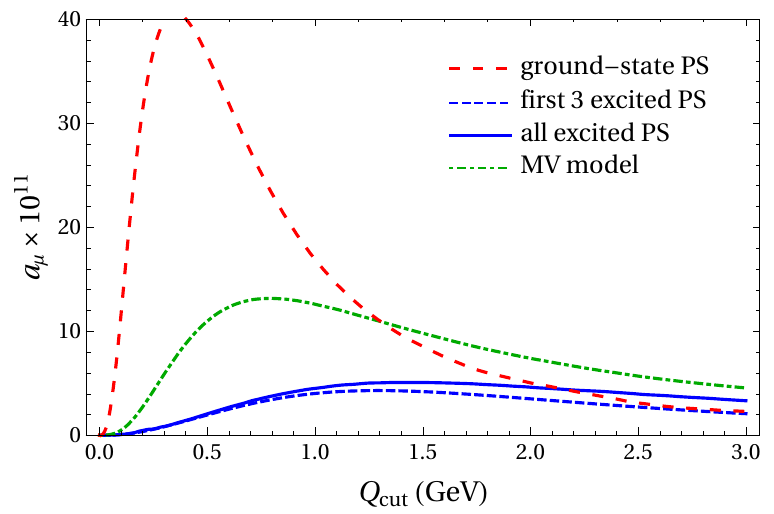
Figure 16. Mixed-region contribution to a (cid:22) , de(cid:12)ned as the full integral minus the contributions from the low-energy (all Q i (cid:20) Q cut ) and high-energy (all Q i (cid:21) Q cut ) regions. preference for a matching scale around Q = 1 : 7 GeV, leading to the match